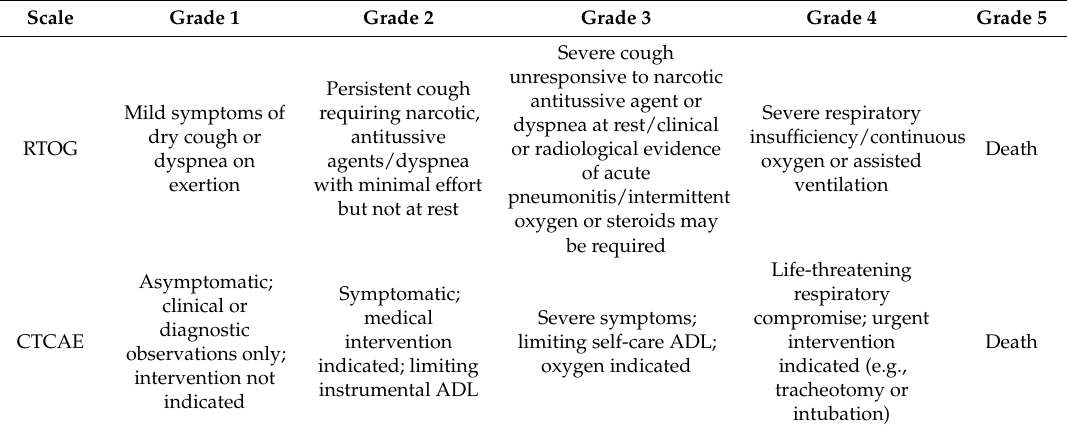
Table 2. Commonly-utilized acute pneumonitis grading